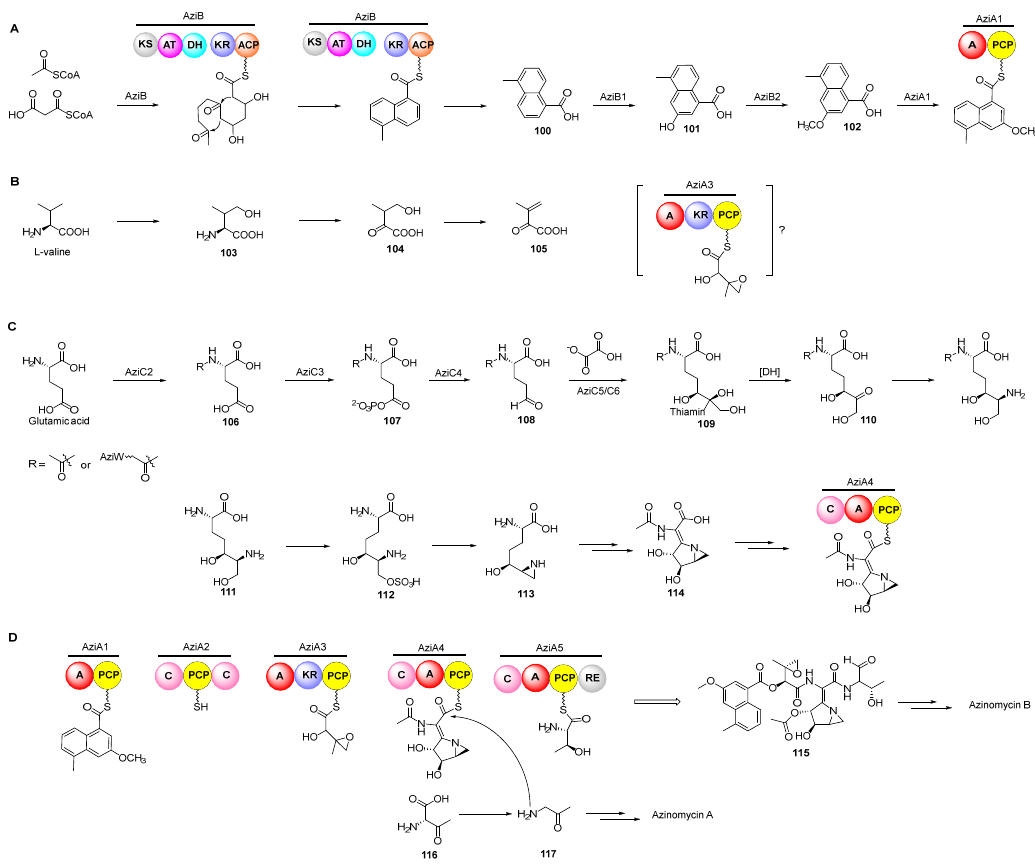
Molecules 2022 , 27 , x FOR PEER REVIEW Figure 13. Origins of azinomycins revealed by isotopic labelling experiments. Figure 13. Origins of azinomycins revealed by isotopic labelling experiments.